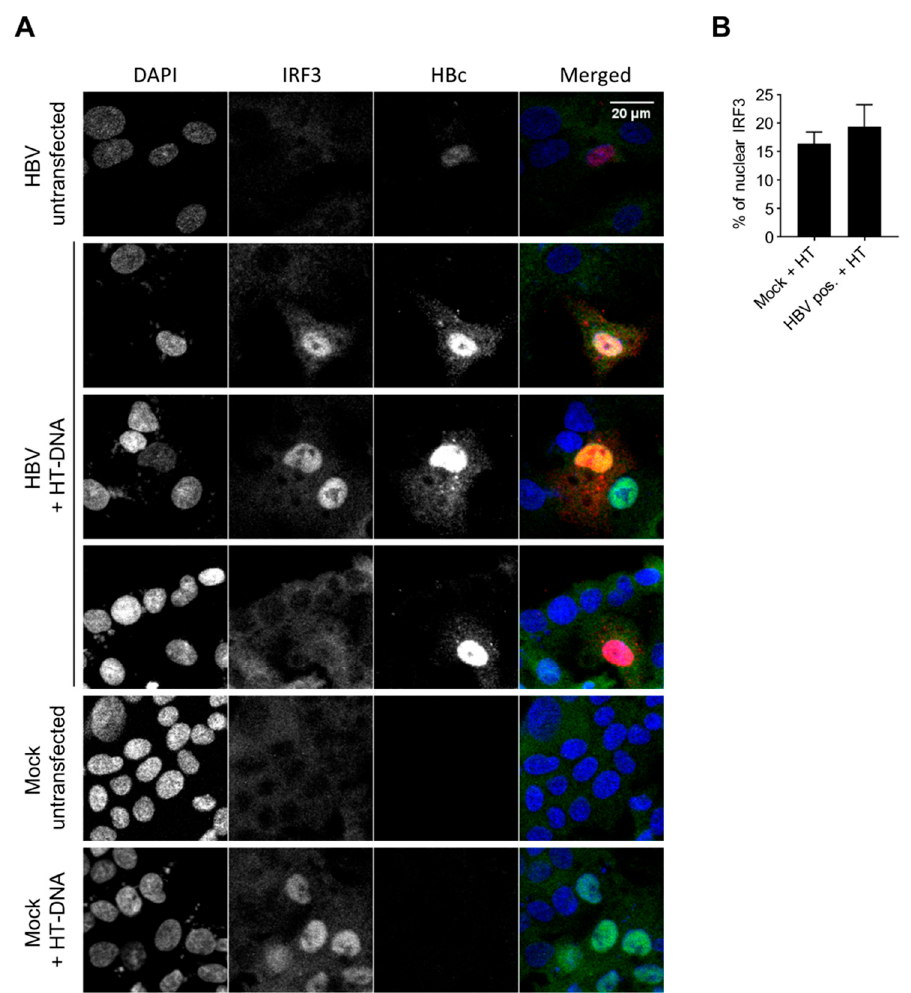
Figure 6. HBV does not inhibit the innate response to foreign DNA. HepG2-hNTCP-cGAS-STING were infected or not with HBVwt (MOI 10000). Seven days post-infection (dpi), the DNA-sensing pathway was stimulated with HT-DNA. Sixteen hours post-HT-DNA-transfection, IRF3 (green), HBc (red) and DNA (blue) were stained. ( A ) Representative images. ( B ) Percentage of nuclear IRF3 counted in HT-DNA transfected cells. For HBV-infected cells, the analysis is restricted to the HBc-positive cells (productive infection). Average and SEM of two independent experiments in duplicates are shown. At least 67 cells per condition and replicate were counted (total: 1153 mock-infected cells; 333 HBc- positive